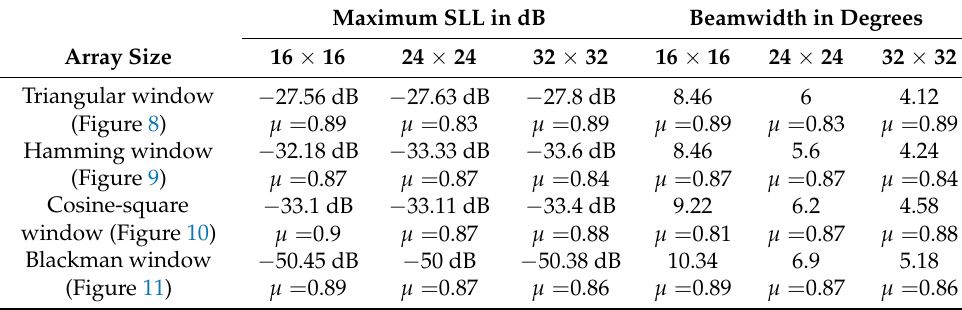
Figure 11. ( a ) Optimizing radial tapered Blackman window at different array sizes. ( b ) Beamwidth variation with the array edge tapering factor at different array sizes. Table 2. Optimum radial tapering of 2D windows at different array